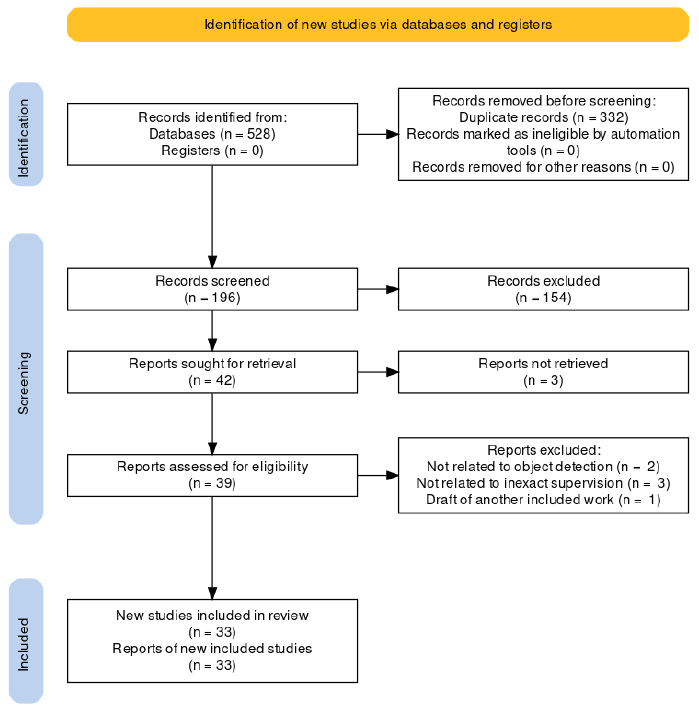
Figure 3. PRISMA flow diagram of the systematic review.